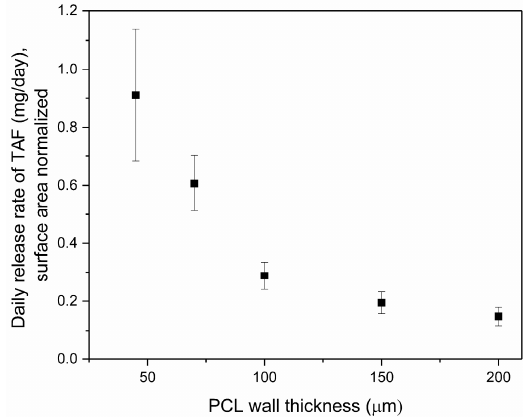
Figure 3. Daily release of TAF (mg/day) from implants with different wall thicknesses as calculated over 35 consecutive days within an in vitro assay. Implants comprised a 2:1 TAF-castor oil formulation (dimensions: 2.5 mm outer diameter (OD) by 40 mm length) fabricated with Sigma-Grade PCL. Three implants were tested per condition.